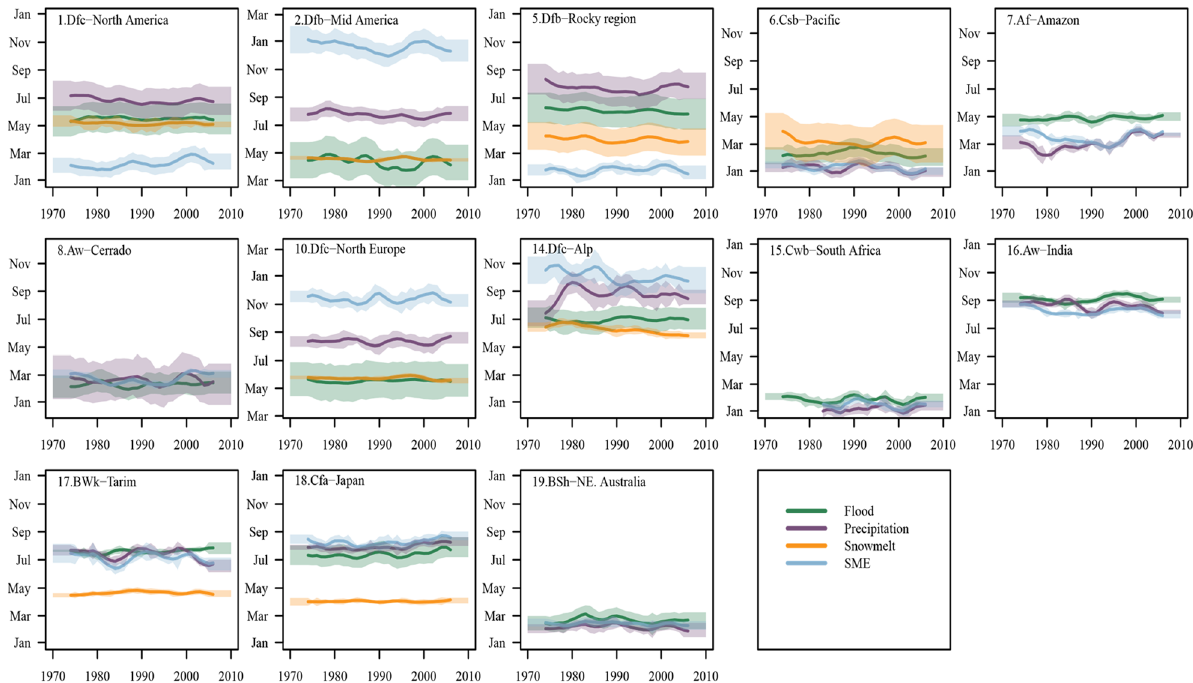
Figure 3. Long-term temporal evolutions of flood timings and their influential factors for 13 hotspots with concentrate index > 0.7. Solid lines show the median timing over the entire hotspot: Green: timing of the observed floods; purple: 7-day maximum precipitation; orange: snow melting indicator and blue: timing of the calculated maximum soil moisture excess (SME). All data were subjected to a 10-year weighted moving average filter. The shaded bands indicate the timing variability within the year (± 0.5 standard deviations). Vertical axes show month of the year (note different starting months in these panels). The precipitation and SME data were started from 1979 in south africa as the CPC precipitation data was started from